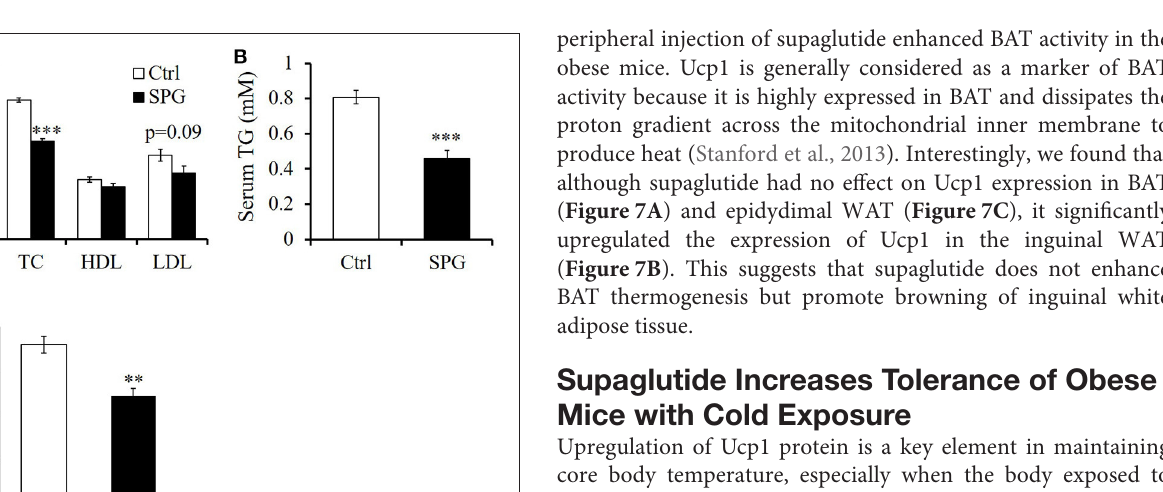
FIGURE 4 | Supaglutide reduces lipid accumulation in the adipose tissues. Left , H&E staining of BAT, inguinal WAT and epididymal WAT; right panel, distributions of adipocyte cell size (Data were collected from H&E-stained sections from five individual mice, five fields per mouse, 5–10 cells per field in each group, using Image J software). Scale bar: 100 µ m, 400 × .